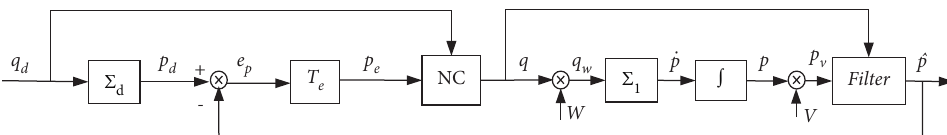
Figure 4: The control block for the USV